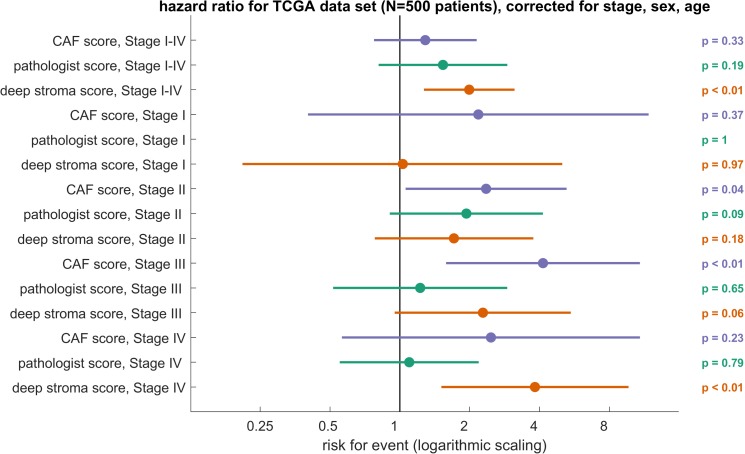
Deep stroma score is an independent prognosticator for shorter OS in the TCGA cohort.HRs with 95% CI in multivariable Cox models including cancer stage (I–IV), sex, and age for a CAF gene expression score, pathologist’s manual quantification of stromal percentage as provided in the TCGA metadata and the deep stroma score. The deep stroma score was binarized into high/low at the median. The other scores (CAF, pathologist) were binarized at an optimal threshold (optimal Youden index). Only the deep stroma score was significantly associated with prognosis in the whole cohort (stage I–IV). The horizontal axis is scaled logarithmically (log 10). CAF, cancer-associated fibroblast; CI, confidence interval; HR, hazard ratio; OS, overall survival; TCGA, The Cancer Genome Atlas.